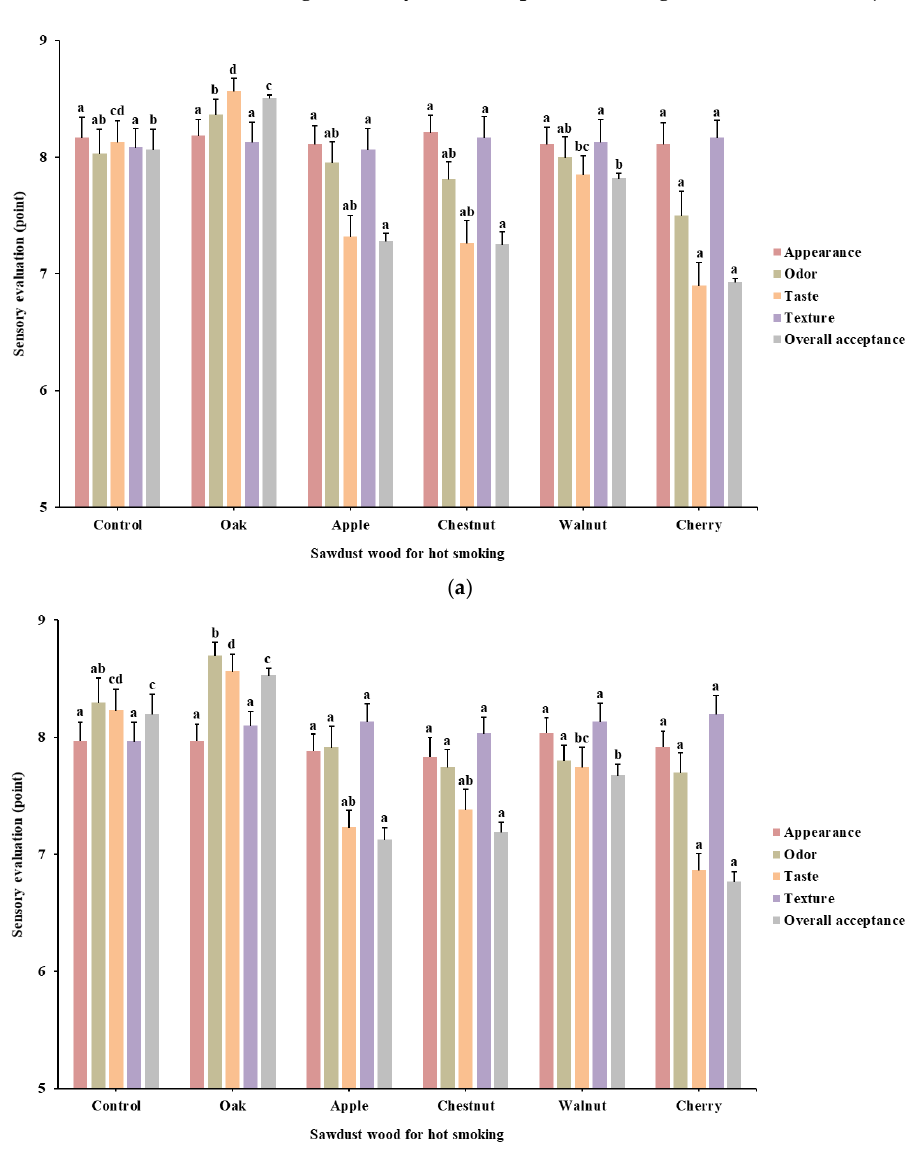
Figure 5. Sensory evaluation of hot-smoked chicken leg and breast with different sawdust: ( a ), chicken leg; ( b ), chicken breast. Values are mean ± SE. Different letters (a–d) in the respective colored column indicate significant differences among the means by Tukey’s test ( p < 0.05).